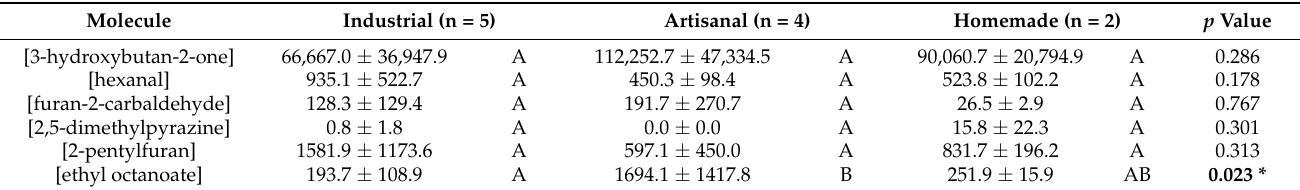
Table 3. Comparison of the six volatile molecules tested with the standard addition method (con- centration in µ g · kg − 1 ) among the three processing methods. Mean values ± standard deviation are shown for each method, with the p value of an ANOVA or Kruskal–Wallis test. Statistical groups determined by post hoc test (Tukey or Conover-Iman, respectively) are indicated by letters. * for p ≤ 0.05, in bold when below the threshold of